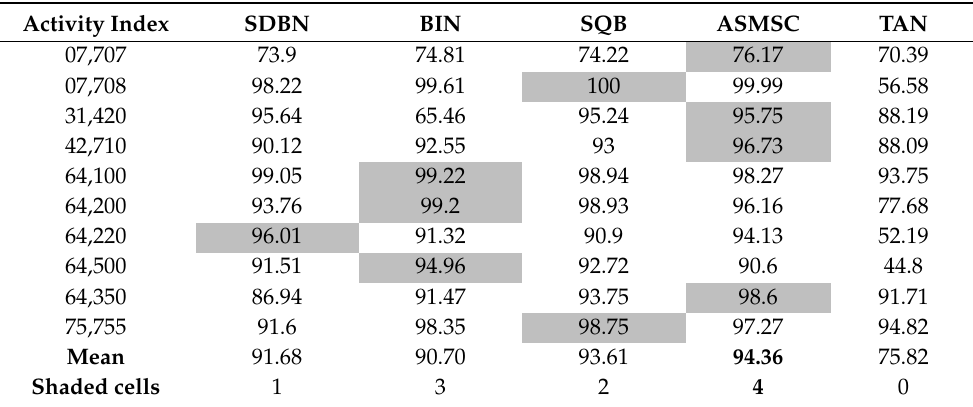
Table 7. Retrieval results of top 5% for MDDR-DS2 dataset.